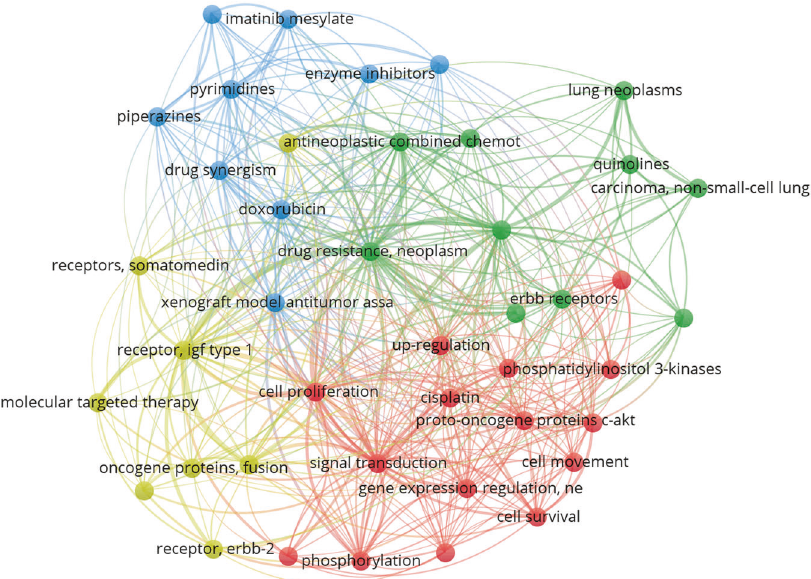
Fig. 4 The research hotspot of TKIs resistance in OS. According to the results of visual analysis, the distribution frequency of keywords of drug resistance-related studies of all TKIs in OS was shown in the fi gure, indicating that the research focuses on IGF-1R, ErbB receptor, AKT, and PI3K